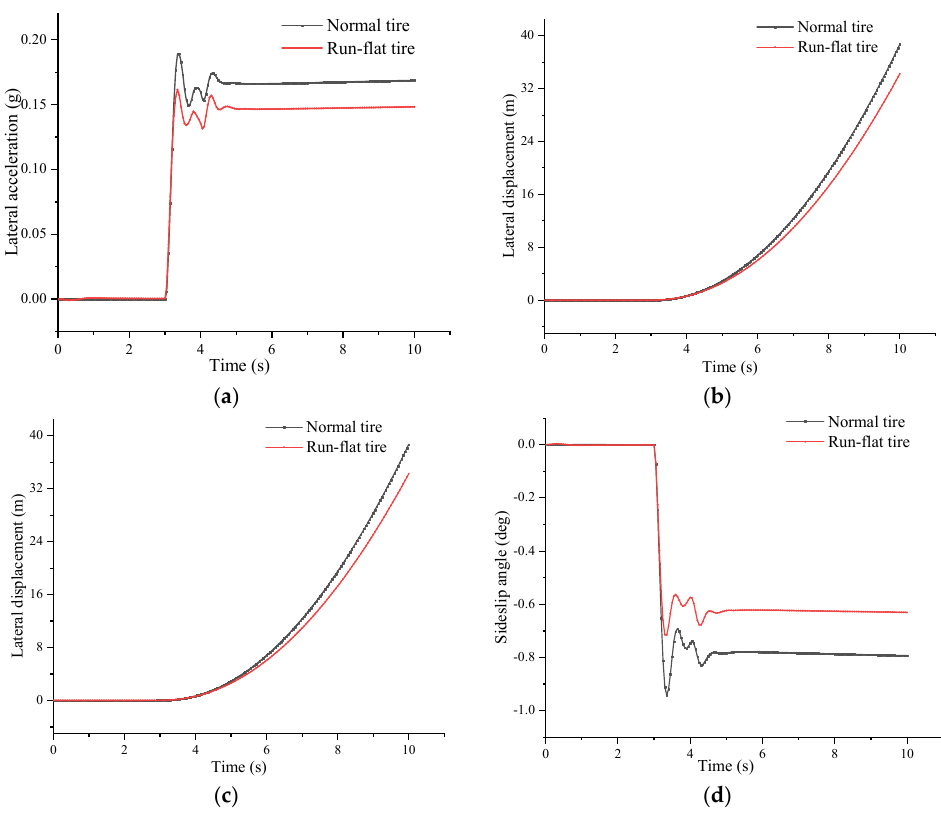
Figure 5. The simulation curve of left rear tire blowout: ( a ) lateral acceleration curve; ( b ) lateral displacement curve; ( c ) yaw rate curve; ( d ) sideslip angle curve.